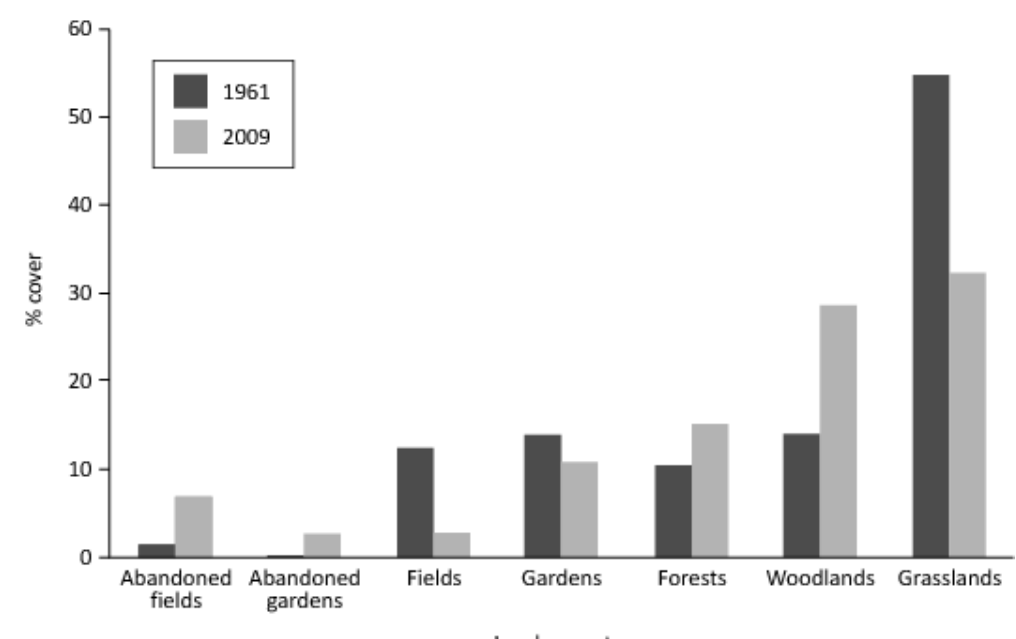
Figure 1. Comparison of land cover between 1961 and 2009 (n = 844 and 949, respectively). doi: